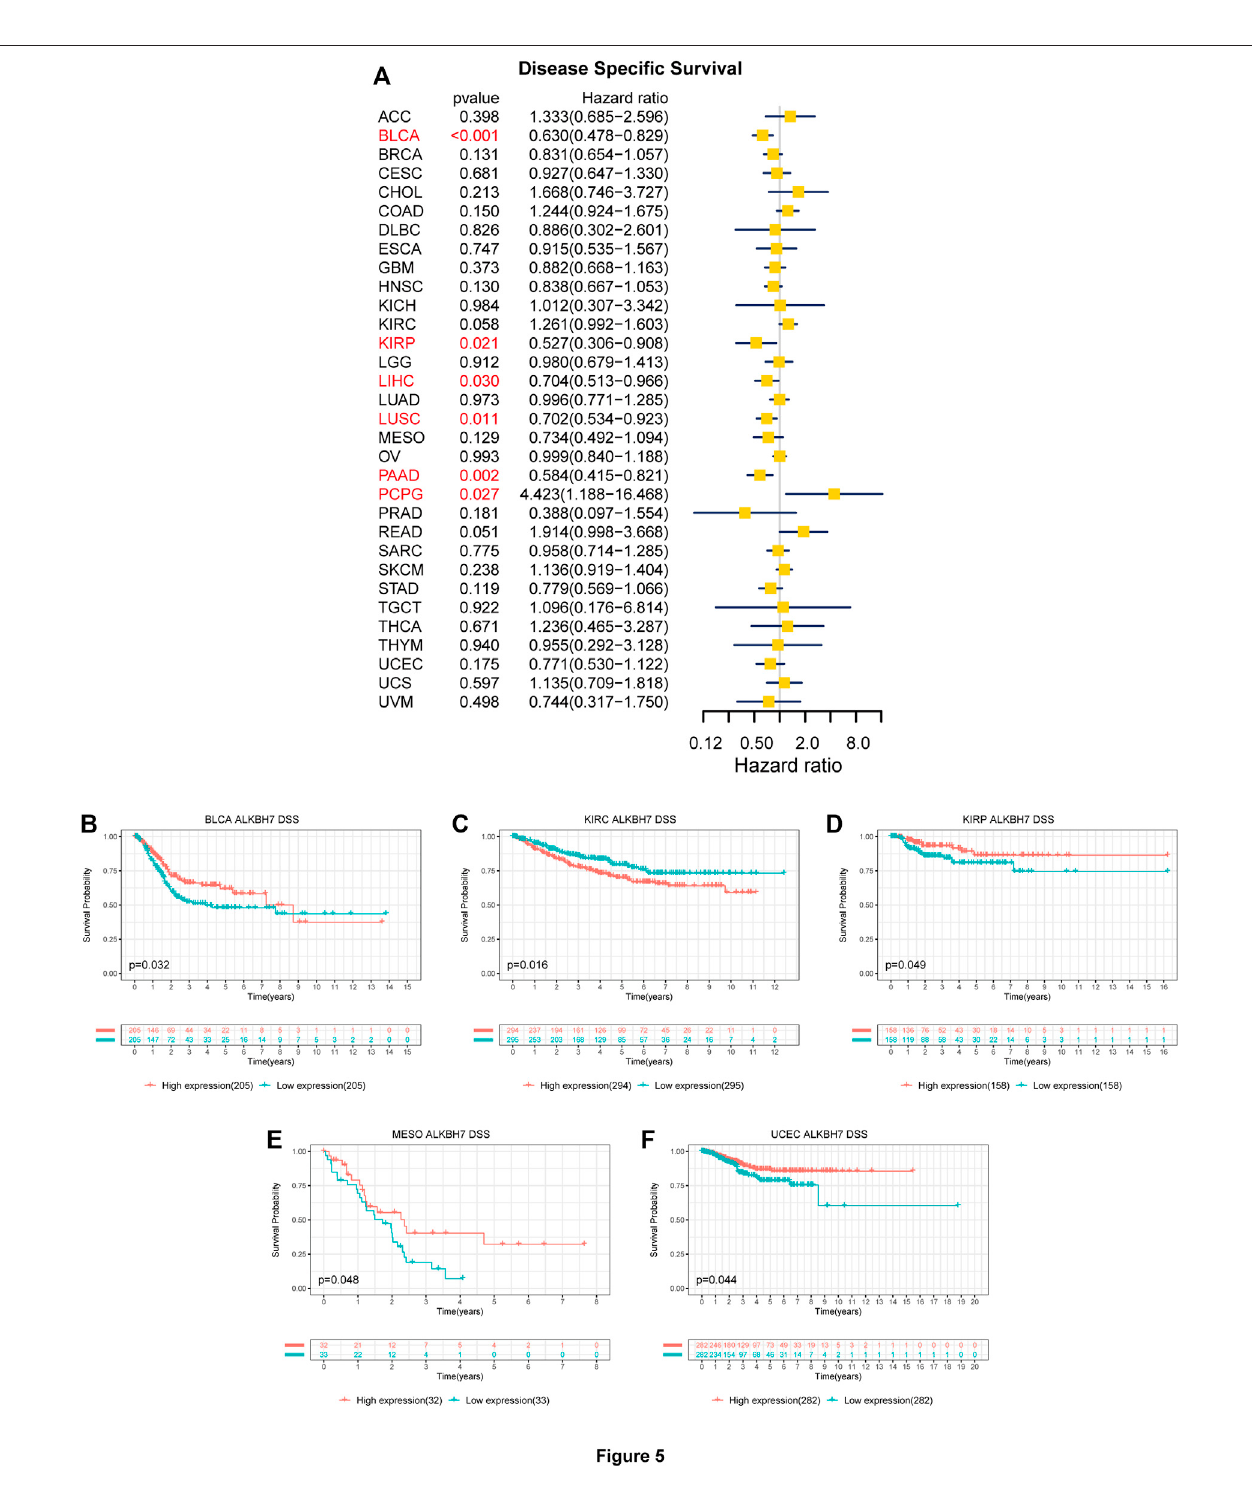
FIGURE 5 | Associations between ALKBH7 expression and DSS of patients with cancer. (A) Forest plot showing hazard ratios of ALKBH7 in 32 cancers; Kaplan- Meier survival curves of DSS forpatients strati fi ed according to different ALKBH7 expression pro fi les in BLCA (B) , KIRC (C) , KIRP (D) , MESO (E) and UCEC (F) .